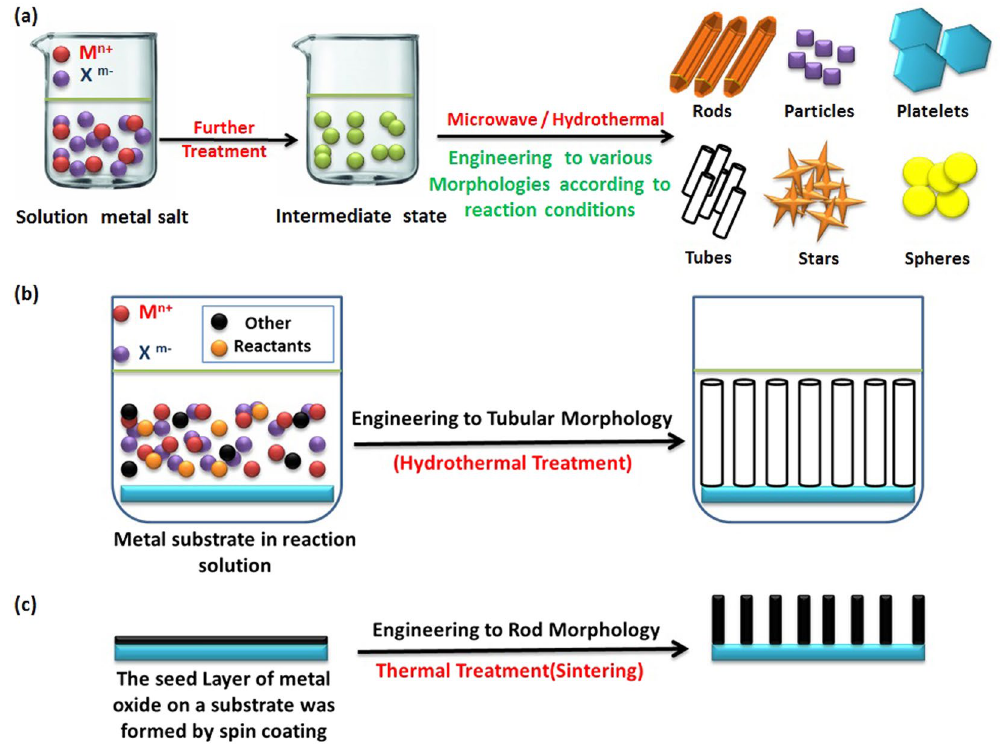
Figure 1. Schematic illustration for the morphology engineering of metal oxides by bottom-up